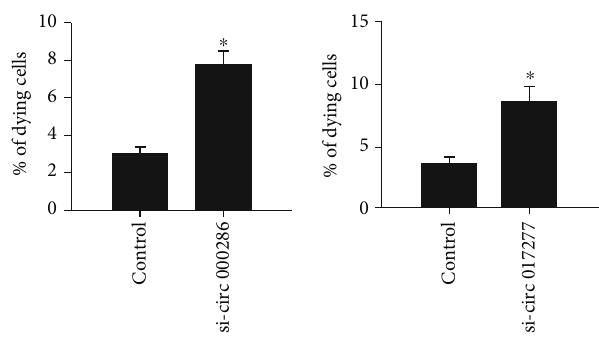
Figure 4: E ff ect of circRNAs 000286 and 017277 on pancreatic- β cell apoptosis. The MIN6 were transfected with circRNA 000286 (left panel) or circRNA 017277 (right panel) siRNAs or negative control. The fraction of dying cells was determined 3 days later by scoring the cells displaying picnotic nuclei upon Hoechst 33342 staining. The results are the mean of three experiments. ∗ P < 0 : 05 , compared with respective control.